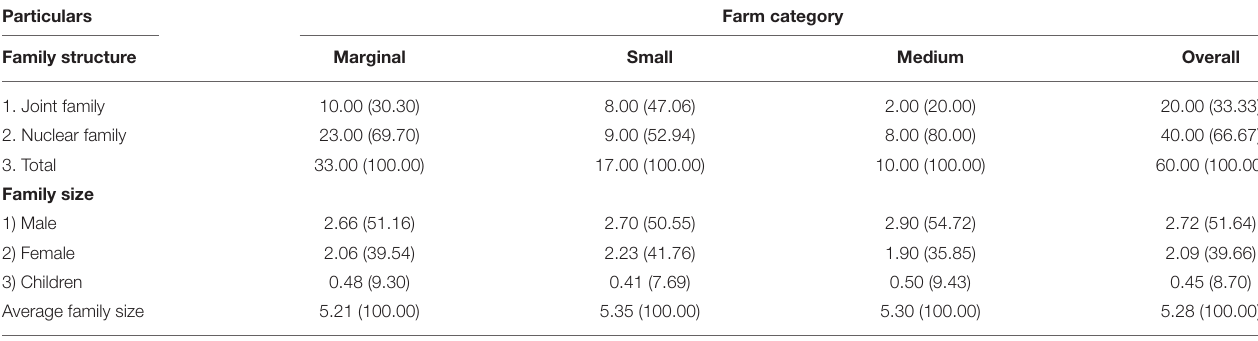
TABLE 3 | Demographic profile of sampled households in the study area (No.). Particulars